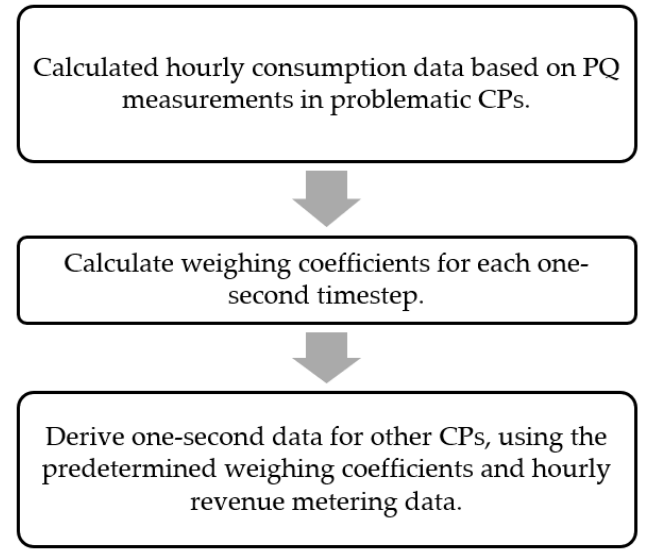
Figure 18. Methodology for deriving one-second data for simulations in other CPs (PQ – power quality).